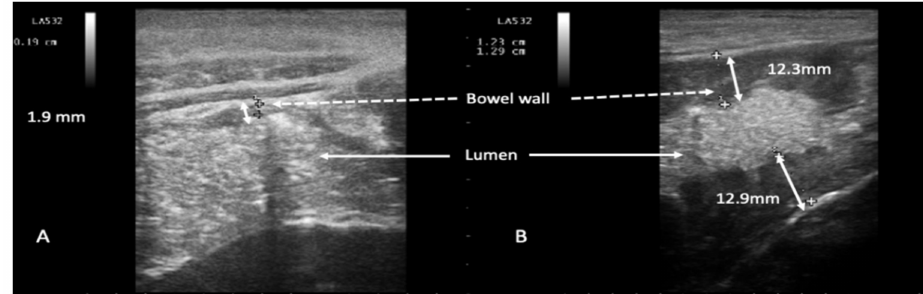
Figure 2. Representative ultrasound imaging of an episode of neutropenic enterocolitis evolved from chemotherapy-induced diarrhea. Chemotherapy-induced diarrhea: mixed solid and liquid content consistent with diarrheal feces in the lumen (panel A ). Neutropenic enterocolitis evolved from chemotherapy-induced diarrhea (panel B ): appearance of abnormal bowel wall thickness. White arrows indicate the colon lumen (panels A , B ); dotted white arrows indicate bowel wall; double white arrows indicate bowel wall thickness (normal, 1.9 mm, in panel A , and abnormally thickened in panel B , 12.3 mm and 12.9